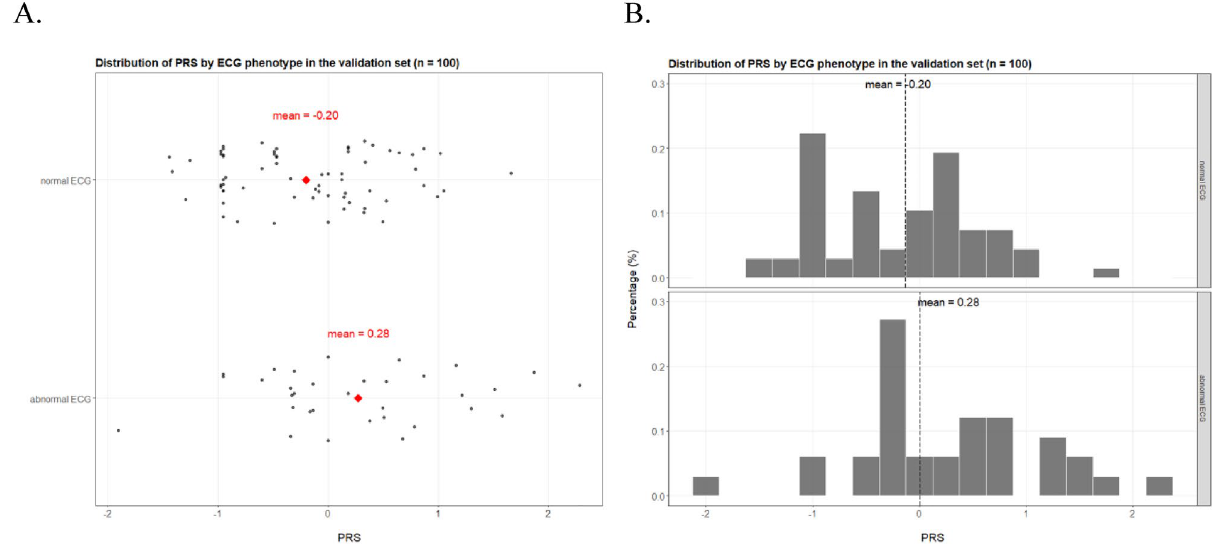
Figure 5. Distribution of PRS by ECG phenotype in the jittered dot plot ( A ) and the histogram ( B ) for the validation